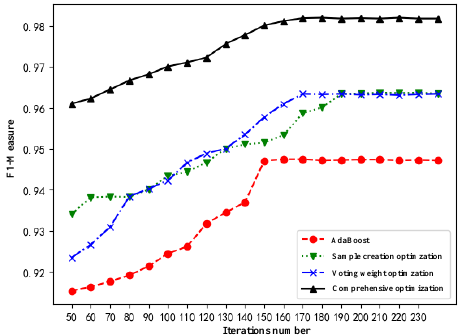
Figure 9. Comparison of AdaBoost model optimization